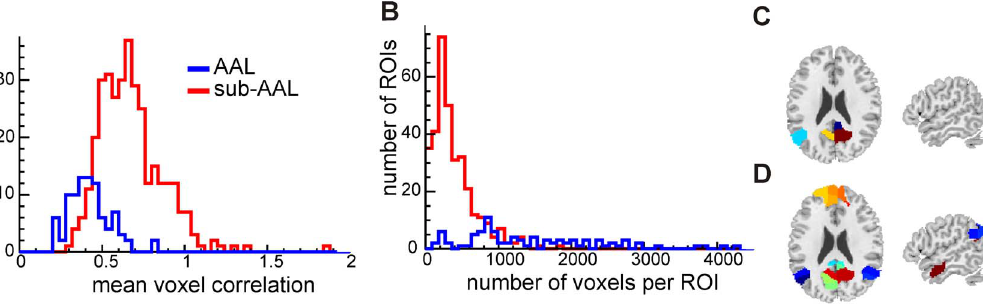
Figure 1. Comparison of the two parcellation approaches. A) The mean voxel correlation (Fisher transformed) within the ROIs for the parcellation according to the AAL atlas and the parcellation derived from the modular structure within the AAL regions (sub-AAL). B) The number of voxels per ROI for AAL and sub-AAL parcellation is plotted. C) ROIs significantly correlated to the left posterior cingulate cortex (PCC) ROI for the AAL parcellation. D) ROIs significantly correlated to the seed ROI in the left PCC for the sub-AAL ROIs.